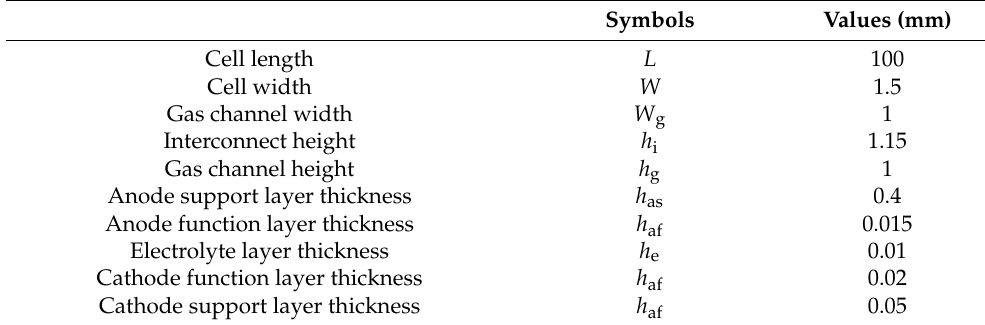
Figure 1. Schematic diagram of solid oxide fuel cell stack and calculation domain in the present work. The detailed geometry parameters of the computational domain are shown in Table 1. Table 1. Geometry parameters of the computational